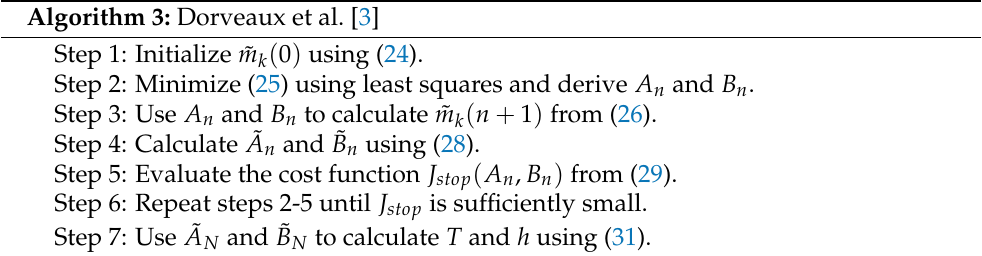
Algorithm 3: Dorveaux et al.